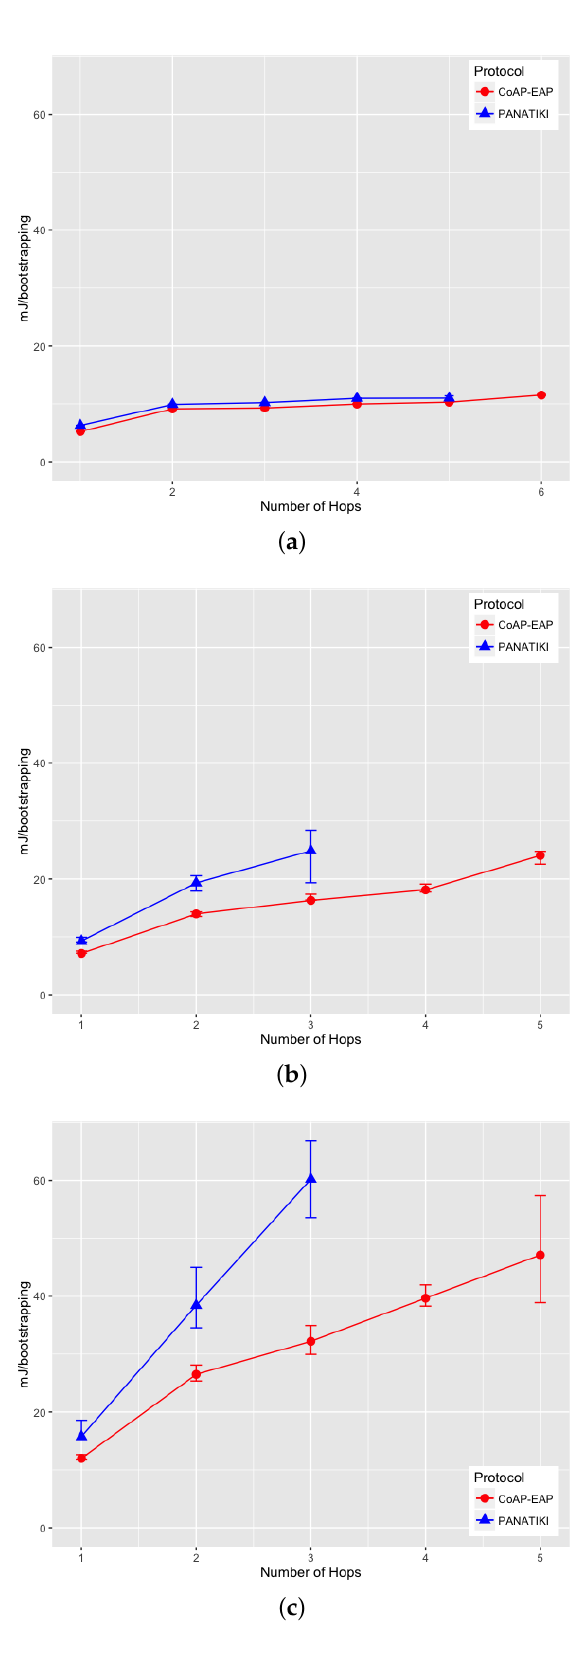
Figure 15. Total energy consumption. ( a ) Total energy consumption with 0.0 loss ratio; ( b ) Total energy consumption with 0.1 loss ratio; ( c ) Total energy consumption with 0.2 loss